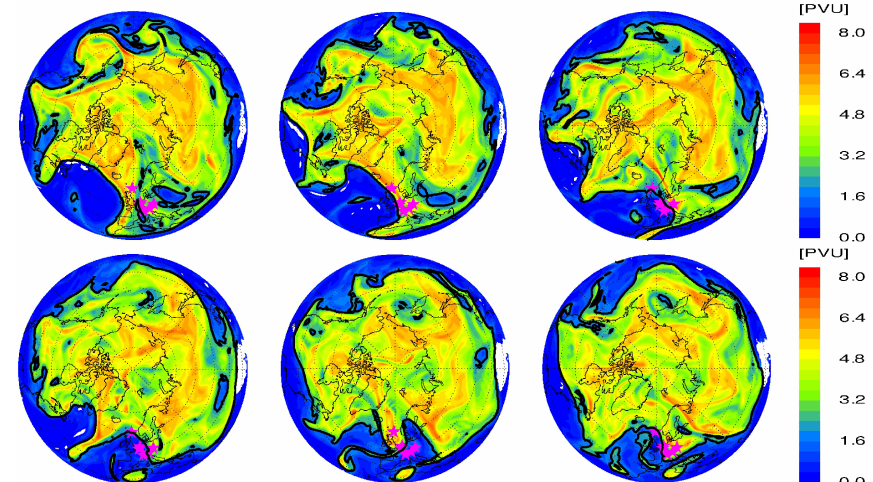
Fig. 5. Ertel’s potential vorticity (PV; × 10 − 6 Km 2 / kgs) at 2 = 325K from 16 to 18 (top row) and 19 to 21 (bottom row) January 2006, from operational analyses of ECMWF for 12:00UT; The six ozone sounding stations are marked by pink stars and the PVU=2 level by the thick black contour line.